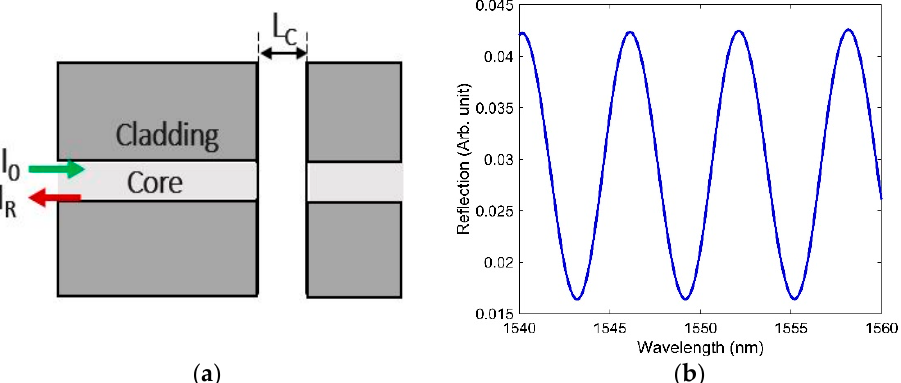
Figure 3. ( a ) Schematic of an EFPI, where I 0 , I R , and L C are the incoming light, reflected light, and cavity length, respectively; ( b ) interferometric fringes obtained due to interference within the cavity length L C = 200 µ m.